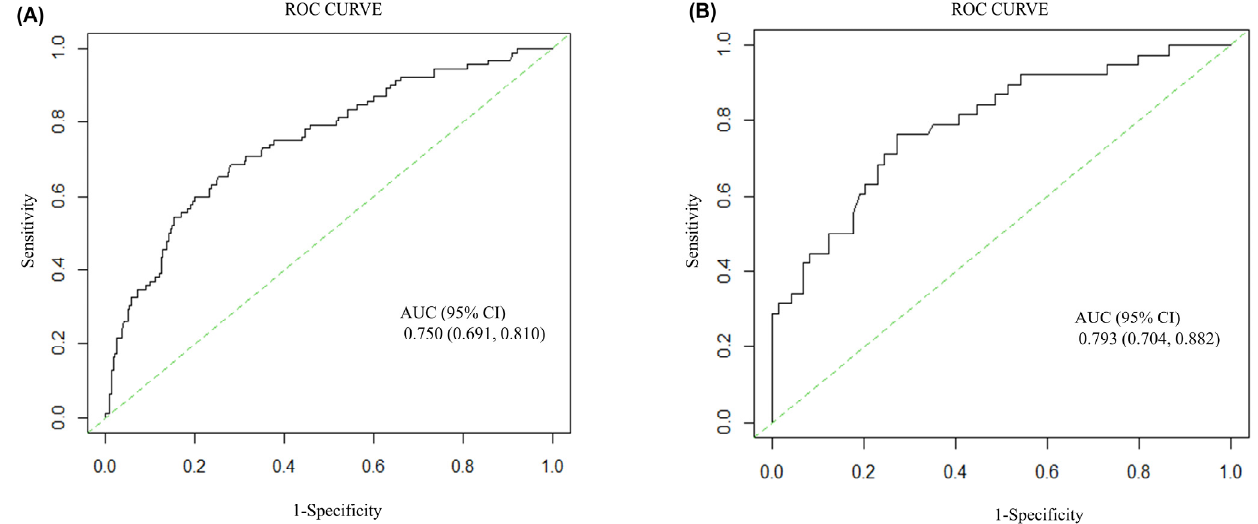
Figure 5. Receiver operating characteristic (ROC) curve for the prediction model for AEx in the training ( A ) and validation ( B ) cohorts. The x-axis, labeled specificity, represents the true-negative rate. The y-axis, labeled sensitivity, represents the true-positive rate. The area under the curve (AUC) and the 95% confidence interval (CI) are shown in the graph. AEx, asthma exacerbation.